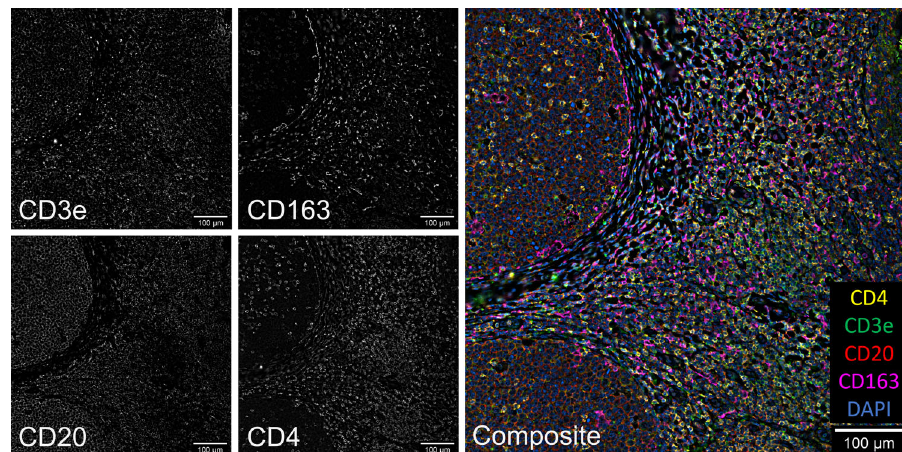
Fig. 2 Combined tyramide-barcode and conjugated primary antibody staining in tonsil. CD3e (1:100 dilution) and CD20 (1:200 dilution) were stained using commercial barcode-conjugated primary antibodies (Akoya Biosciences), and staining of CD4 and CD163 was performed using tyramide-barcodes with mouse anti-CD4 (1:100 dilution, clone 4B12, Leica Biosystems) and mouse anti-CD163 (ready-to-use format, clone 10D6, Leica Biosystems) primary antibodies. The composite image is colored as follows: DAPI = blue, CD20 = red, CD4 = yellow, CD3e = green, and CD163 = magenta. The Keyence BZ- X800 microscope used 100% excitation intensity, High Resolution imaging mode, and a Nikon 20x PlanApo lambda 0.75 NA objective. Background subtraction and image stitching were performed using Akoya ’ s CODEX Processor